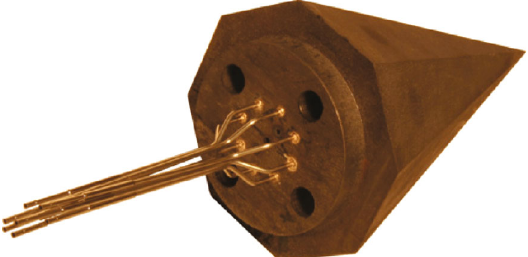
Figure 10: SHEFEX II sharp leading edge with pressure